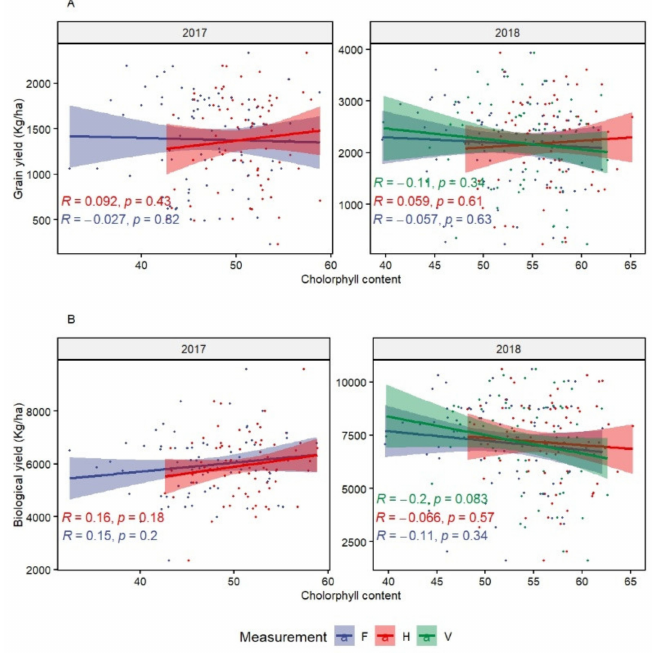
Figure 7. Linear regression and the Pearson correlation coefficient of chlorophyll content measured at vegetative stage (V), heading (H), and grain filling (F) versus grain yield ( A ) and biological yield ( B ) under continuous heat stress for two seasons (2016–2017 and 2017–2018).